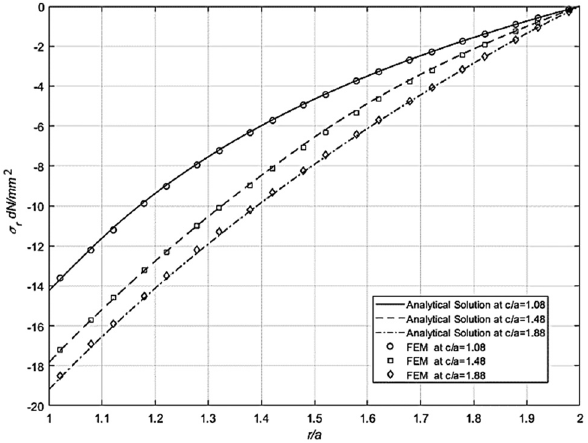
Figure 3: Variation of internal pressure during the elastic – plastic expansion.